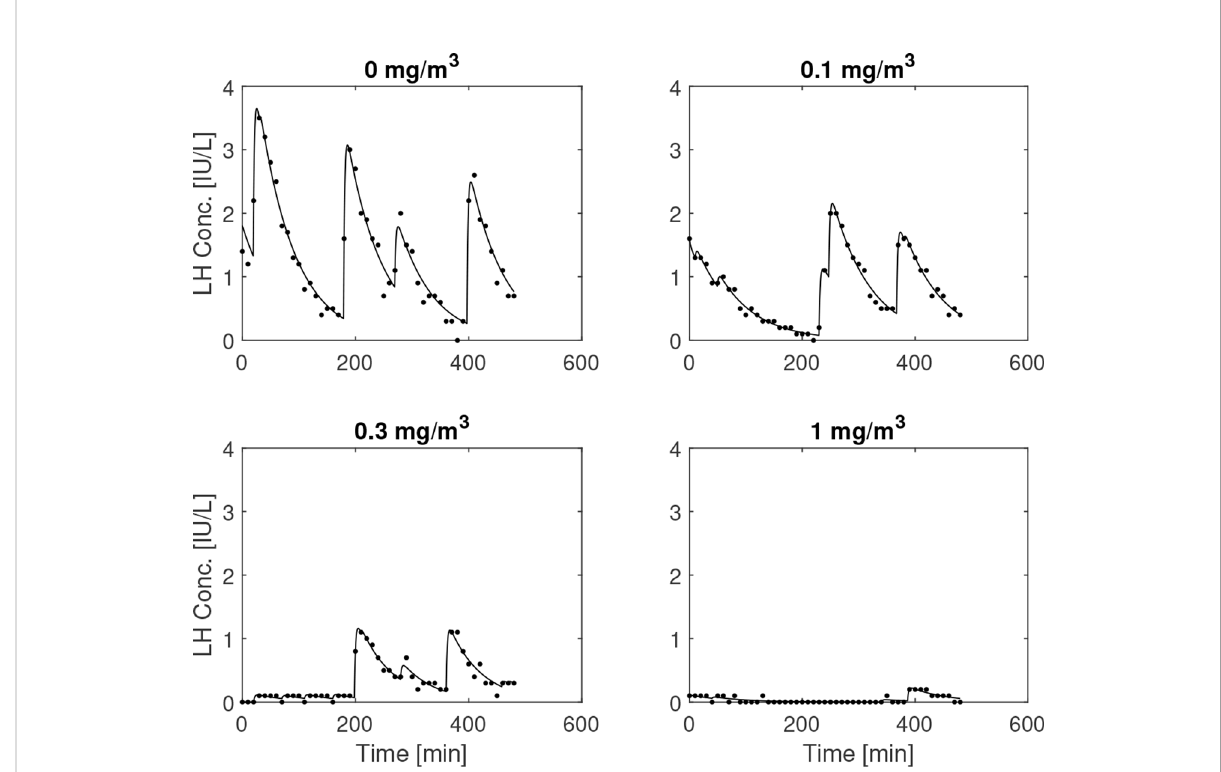
FIGURE 8 Simulated and measured LH concentration for escalating doses of ganirelix administered to a 24-year-old. The medication tends to lower both the amplitude and the frequency of the pulsatile episodes for this